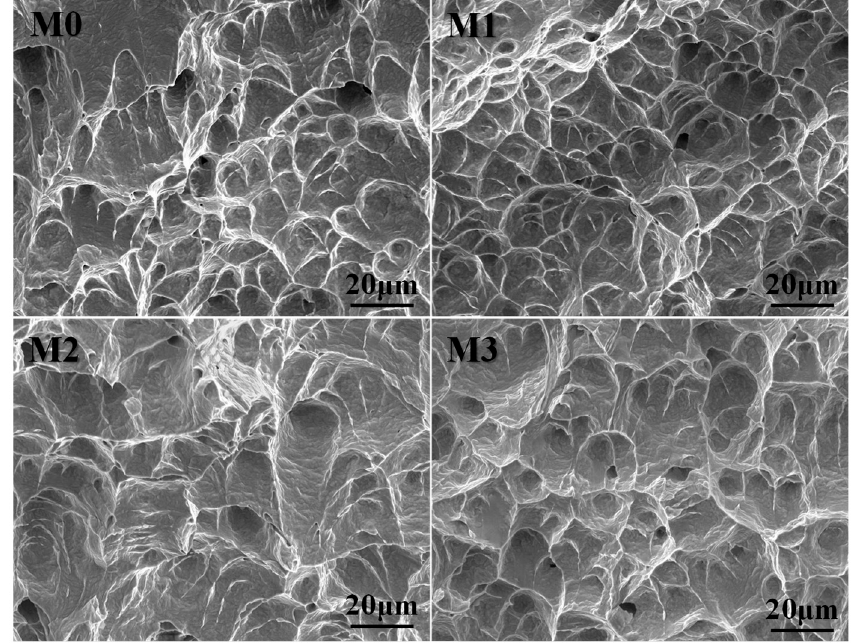
Figure 6. Morphologies of the fracture surfaces of the unaged cast duplex stainless steel (CDSS) specimens. (M0, M1, M2, and M3 corresponds the alloy with Mo content of 0.0, 0.20, 0.90, and 1.75 wt%, respectively.)